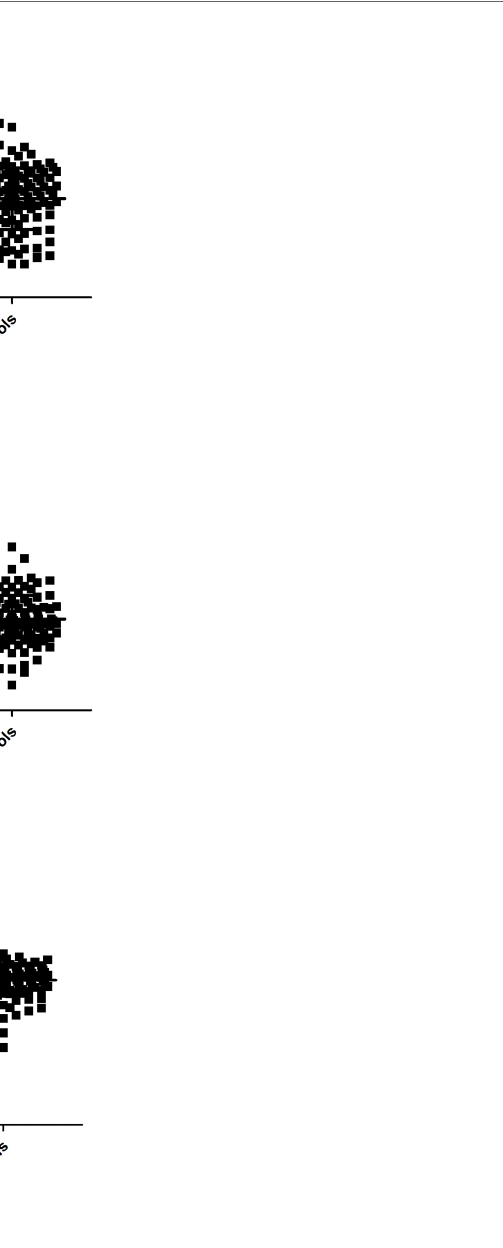
FIGURE 1 | The methyation levels of AHR, ARNT, AHRR between RA patients and